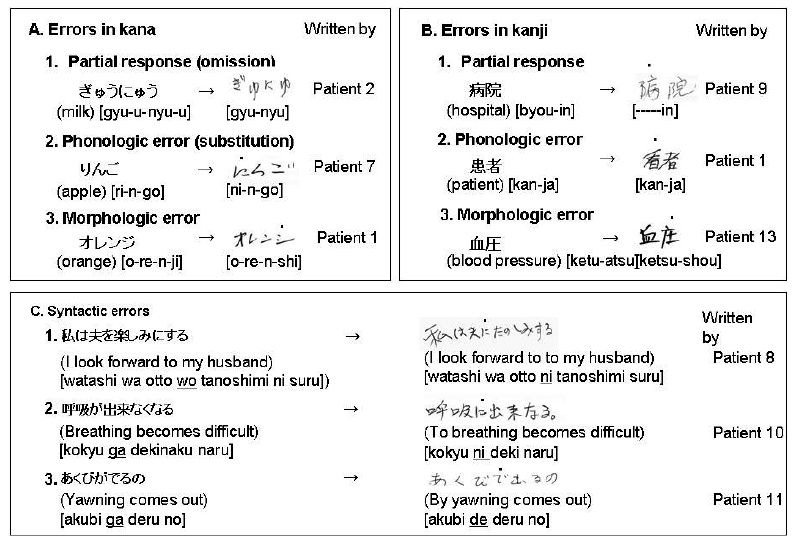
Fig. 1. Samples of writing errors observed in the study. Samples of writing errors in kana (A) and kanji (B) are shown in the upper half of the figure. For each type of error the correct text is typed on the left of the arrow and the samples written by the patients themselves are on the right with the wrong letters indicated by dots for all errors except omission. The corresponding English and the pronunciation for correct and incorrect text are shown below each word in the parentheses and blankets, respectively. Writing errors in kana, included partial responses, with omission of one or more kanas that constitute a kana word (A-1); phonologic errors, in which one or more kanas that constitute a kana word is substituted for other kanas (A-2); and morphologic errors, with omission or addition of a component of kana (A-3). Writing errors in kanji included partial responses, in which part of the kanji components were correct but the written kanji does not really exist (B-1); phonologic errors, with substitution of another kanji that has the same value as the correct component but a different meaning (B-2); and morphologic error, with substitution of another kanji that has visual resemblance to the correct component (B-3). Samples of syntactic errors are shown in the lower half of the figure (C). Mistakes with postpositions (prepositions) are indicated by dots in each sentence written by patients and the corresponding pronunciation is underlined. Mistakes included misuse of a postposition that modifies an indirect object instead of a postposition that modifies a direct object (C-1); misuse of a postposition that modifies an indirect object instead of a postposition that modifies a subject (C-2); and misuse of a postposition that modifies an adverb instead of a postposition that modifies a subject